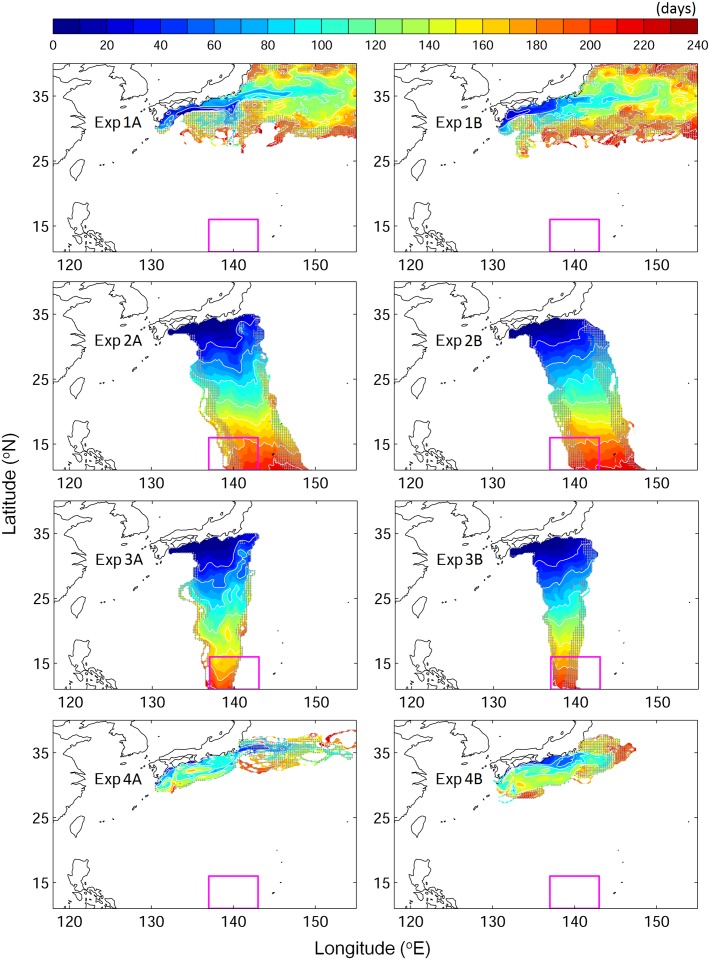
Time evolution (days) of the depth-integrated trajectories of v-eels for each tested scenario at swimming speed of 0.15 m s−1.Left panels are for cases A in which the Kuroshio is strong, and right panels are for cases B in which Kuroshio is weak. (from top to bottom) Exp. 1 (random), Exp. 2 (compass), Exp. 3 (true navigation), and Exp. 4 (against Kuroshio). Gray dots mark the locations where the number of v-eels is less than 1%. The magenta box shows the spawning area.